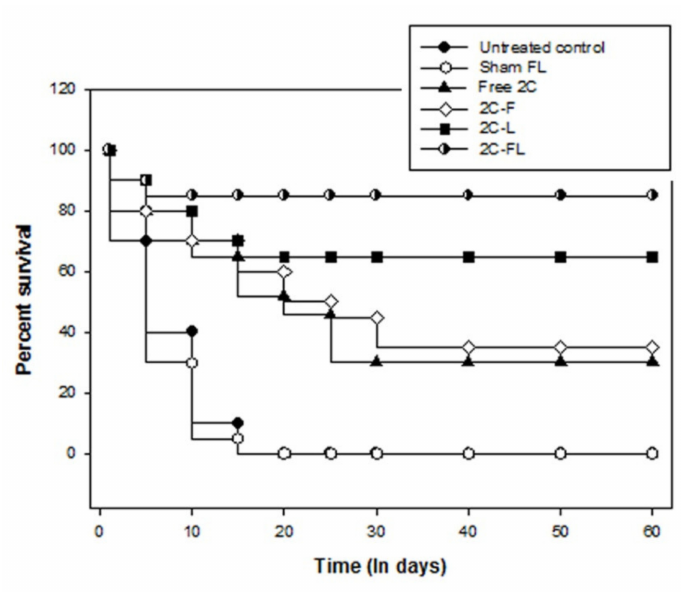
Figure 8. The survival rate of C. albicans -infected mice after the treatment with 2C-encapsulated formulations. Survival of mice was recorded for 60 days